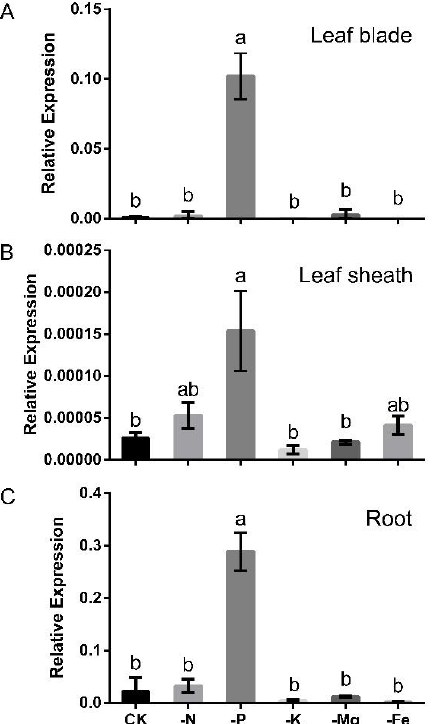
Figure 1. Variable effects of nutrient deficiencies on OsLPR3 transcript levels. Wild-type rice (Nipponbare) seedlings (10-d-old) were grown for 7 d in complete nutrient solution (CK) or in nutrient solution lacking nitrogen ( − N), phosphorus ( − P), potassium ( − K), magnesium ( − Mg), or iron ( − Fe). Relative OsLPR3 transcript levels of leaf blades ( A ), leaf sheaths ( B ), and root ( C ) samples were determined and compared with OsActin1 via qPCR. Values are means ± SE ( n = 3). Different letters above the bars indicate significant differences in the relative OsLPR3 transcript levels ( p < 0.05, one-way ANOVA).